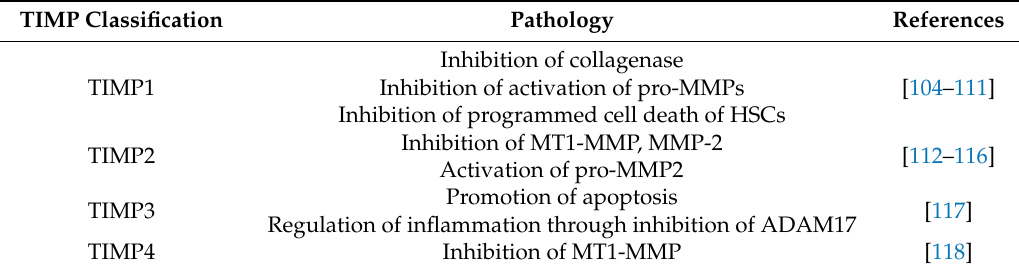
Table 5. Summary of tissue inhibitors of metalloproteinase. TIMP